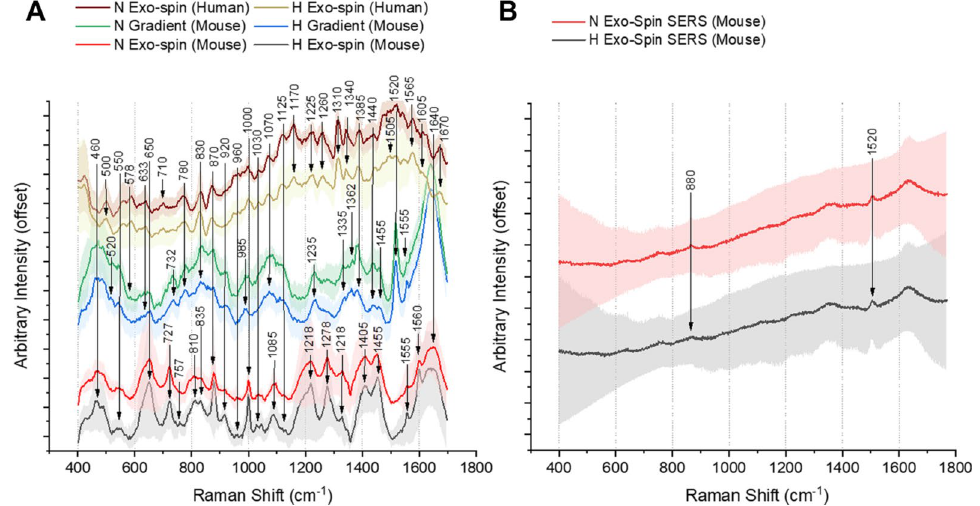
Figure 3.. Influence of background fluorescence on RS measurements. The difference between mouse and human RCC with different spectrometer setups ( A ): TG-RS average spectra (λ exc = 532 nm) of EVs isolated with density gradient (green and blue) and Exo-spin (red, black, brown, beige) and ( B ) conventional continuous wave excitation Raman (λ exc = 514 nm) on average spectra of mouse RCC for normoxia (N—red) and hypoxia (H— black) EV